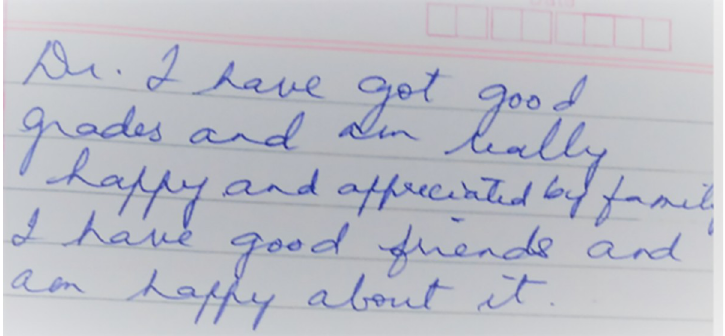
Fig 6. Appreciating family and friends—Journal entry © B9, adolescent male, 18